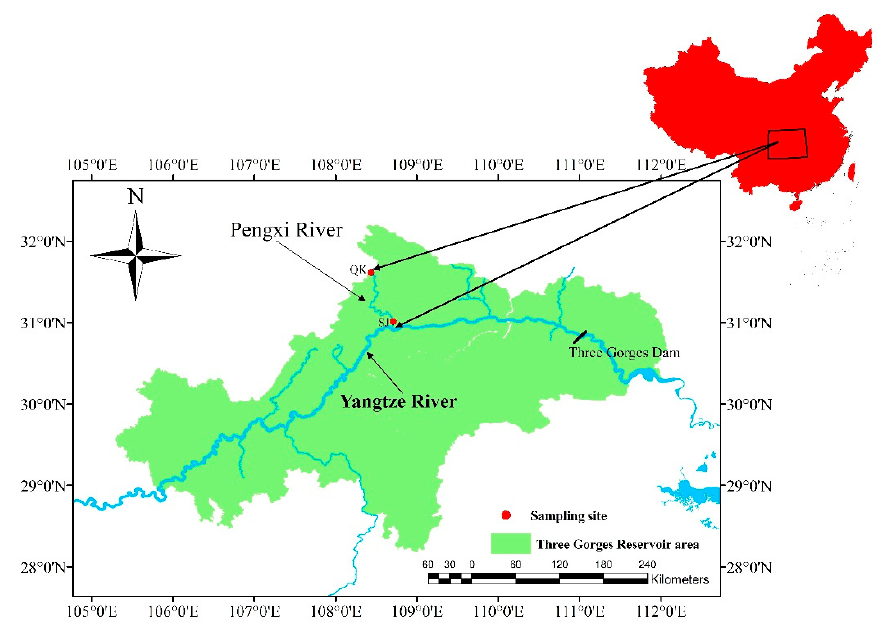
Figure 1. Sampling sites in the Pengxi River (QK: Qukou; SJ: Shuangjiang).